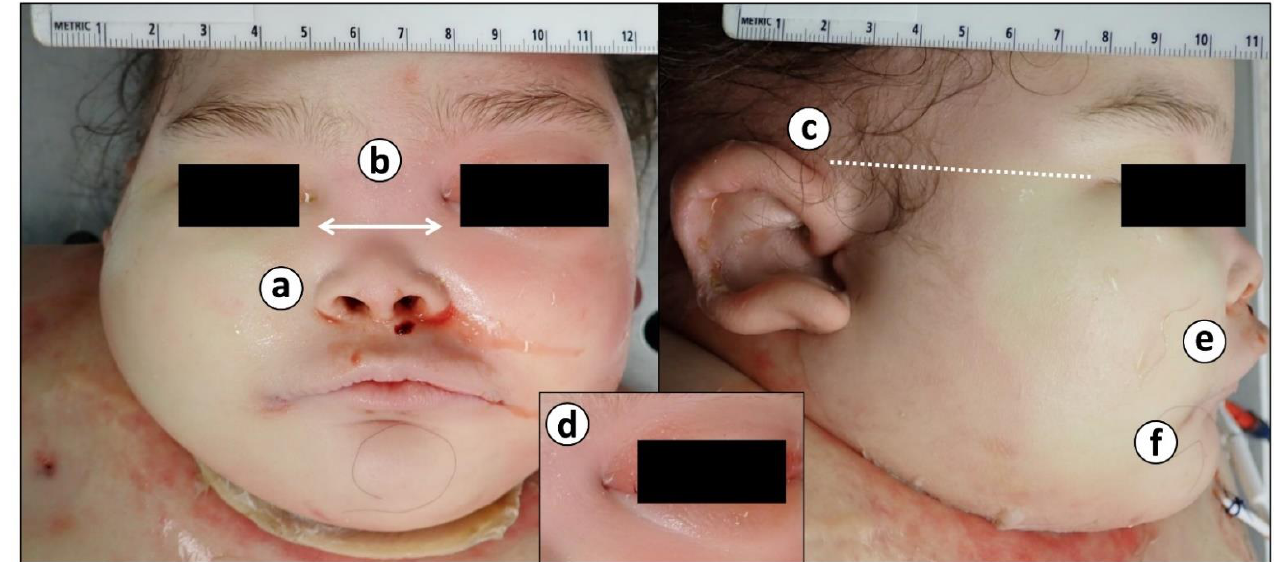
Figure 1. Syndromic facial features associated with Miller – Dieker syndrome. Images of the patient’s face showing ( a ) small and upturned nose with anteverted nares, ( b ) hypertelorism (abnormally increased distance between eyes) with wide nasal bridge (inner-canthal distance 2.8 cm), ( c ) low-set and posteriorly-rotated ears, ( d ) upslanted palpebral fissures with epicanthus supraciliaris (referring to a vertical fold of skin that extends from just below the brow to an area just over the infraorbital rim, usually obscuring the caruncle [10]), ( e ) thick upper lip with a thin, downward facing vermilion upper border and short philtrum, and ( f ) micrognathia.